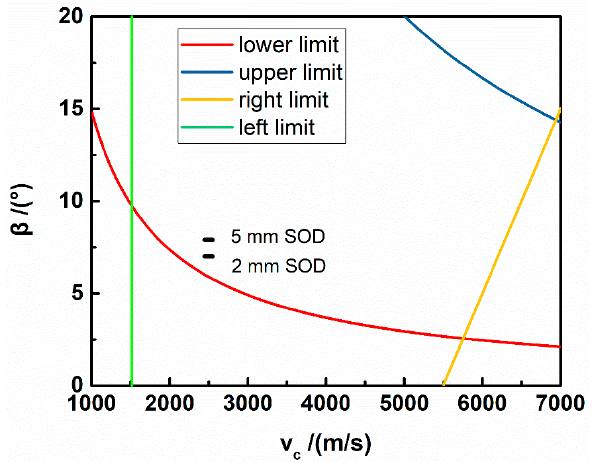
Figure 2. The explosive weldability window of HEAs and